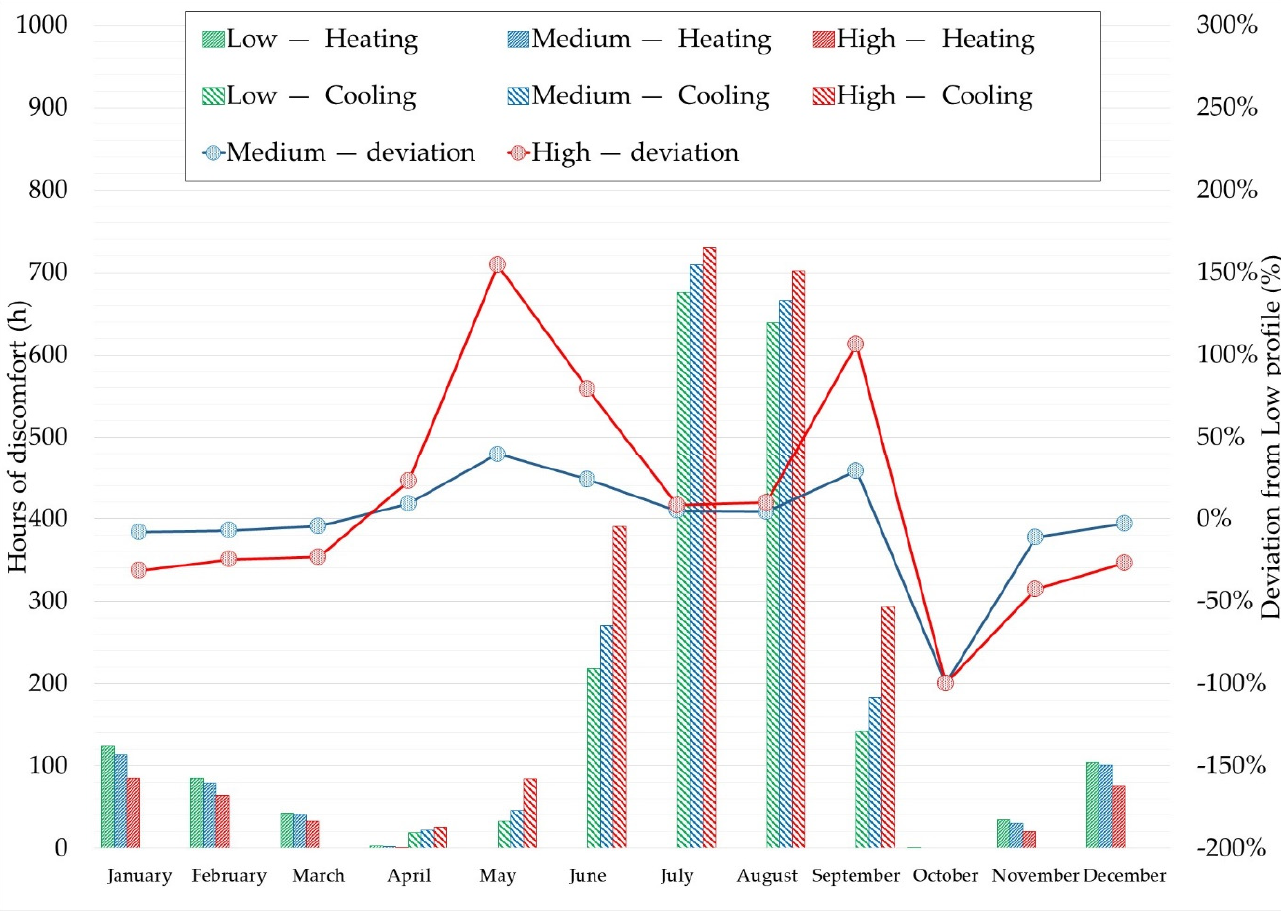
Figure 10. Number of discomfort hours simulated within the environment during the heating period for the three defined profiles.